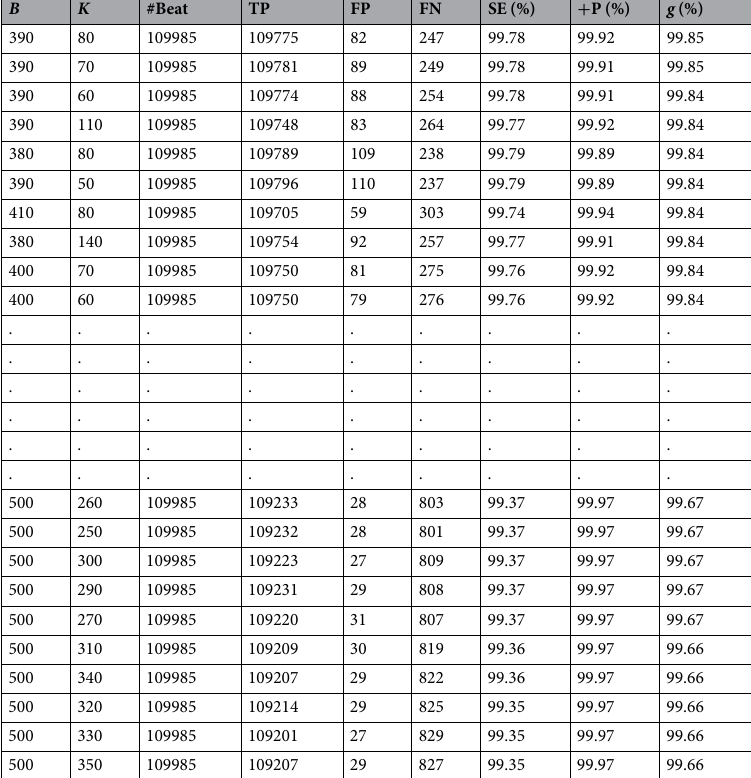
with an SE of 99.78% and a + P of 99.92%. It is clear that the highest accuracy of QRS detection was scored using Method III with B / K = 4.875. The results of Method III will be discussed in more detail. A summary of the QRS detection results for all recordings using Method III with B / K = 4.875 is shown in Table 2. Figures 2, 3 and 4 show the performance of Method III under noisy conditions. The first plot (a) in each figure shows the original ECG signal. The second plot (b) shows the compressed ECG signal using Method III. The third plot (c) shows the QRS detection based on the compressed signal shown in plot (b). Figure 2 shows the perfor- mance of the QRS detector on a compressed ECG signal using Method III over T waves with large amplitudes, which are often misidentified as QRS peaks due to their amplitude. Figure 3 shows the QRS detection performance using an ECG signal with premature ventricular contractions, which introduce irregular heartbeats in terms of RR interval and morphology. Figure 4 shows that the QRS detec- tor performed well in the presence of noise and baseline wandering within the compressed ECG signal. Table 3 compares the QRS detection performance of well-known compression algorithms with the proposed methods. As shown, Method III outperformed all competing lossless algorithms in terms of increasing BCR and decreasing PRD simultaneously. The multiscale morphology technique scored lower in detection accuracy given its high computational complexity. In comparison, Method III was fast and more efficient for analyzing ECG signals making it better suited for e-health applications. Table 4 compares the compression performance of the four methods with other compression schemes imple- mented on hardware for wearable applications. Method III outperformed existing well-known lossy and loss- less compression methods by scoring the highest BCR at 4.5 while scoring the lowest PRD at 0.53. Note that Methods III and III have already outperformed the state-of-the-art lossless compression methods: delta predictor/ Rice-Golomb coding 10 , adaptive predictor/Huffman coding 11 , simple predictor/Huffman coding 12 , and slope pre- dictor/fixed-length packaging methods 13 in terms of increasing BCR and decreasing PRD simultaneously. The higher the BCR and the lower PRD values in an algorithm, the better the compression performance However, the detection of QRS has to be considered when choosing the optimal compression algorithm. In this study, the proposed detector was implemented in MATLAB 2012a (MathWorks, Inc., Natick, MA, USA) on an Intel ™ i5 CPU with 2.27 GHz. Figure 5 shows the BCR versus QRS detection performance and processing time. As expected, the processing time decreased as the BCR increased. Method III took an average